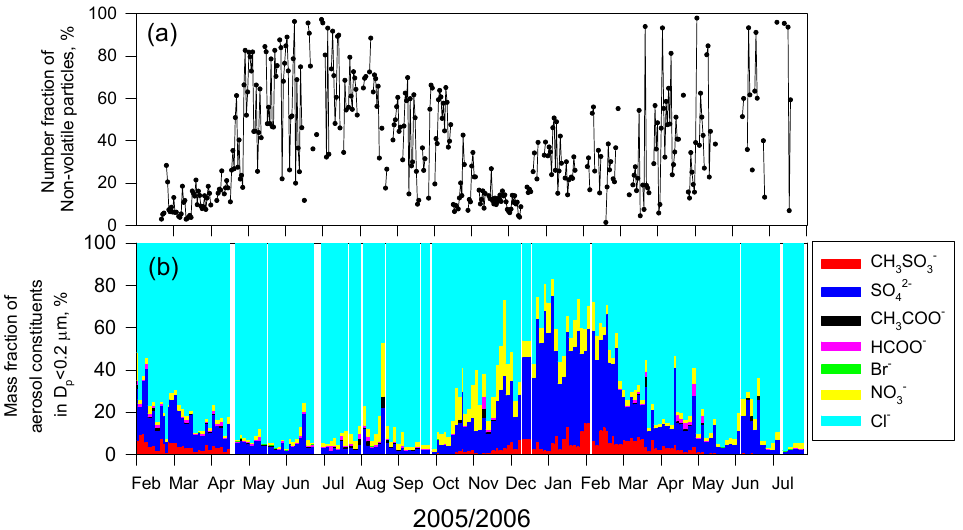
Fig. 7. Seasonal variations of the number fraction of non-volatile particles and mass fraction of water-soluble aerosol constituents of anions in D p < 0 . 2µm at Syowa